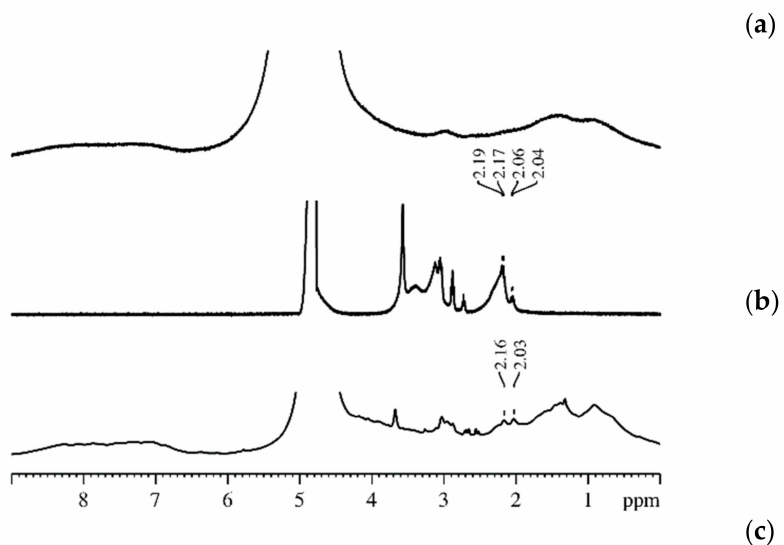
Figure 68. 1 H spin–echo NMR spectra at low gradient amplitude pulses g : ( a ) RBCs suspension, g = 50 G/cm (0–1.70 ppm: (CH 2 ) n and CH 3 groups of lipids; 6–9 ppm: protein component (protons of aromatic rings and NH and OH groups)); ( b ) fullerene derivative 1 in aqueous solution, g = 55